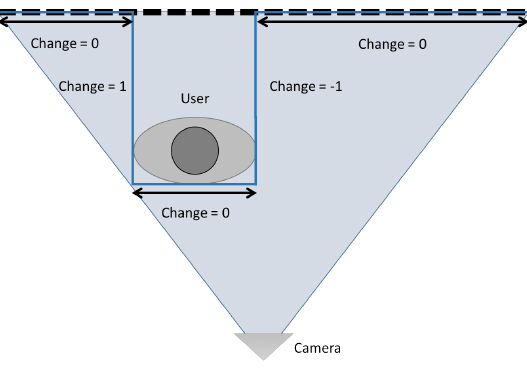
Figure 3. Depth changes produced by a user in the